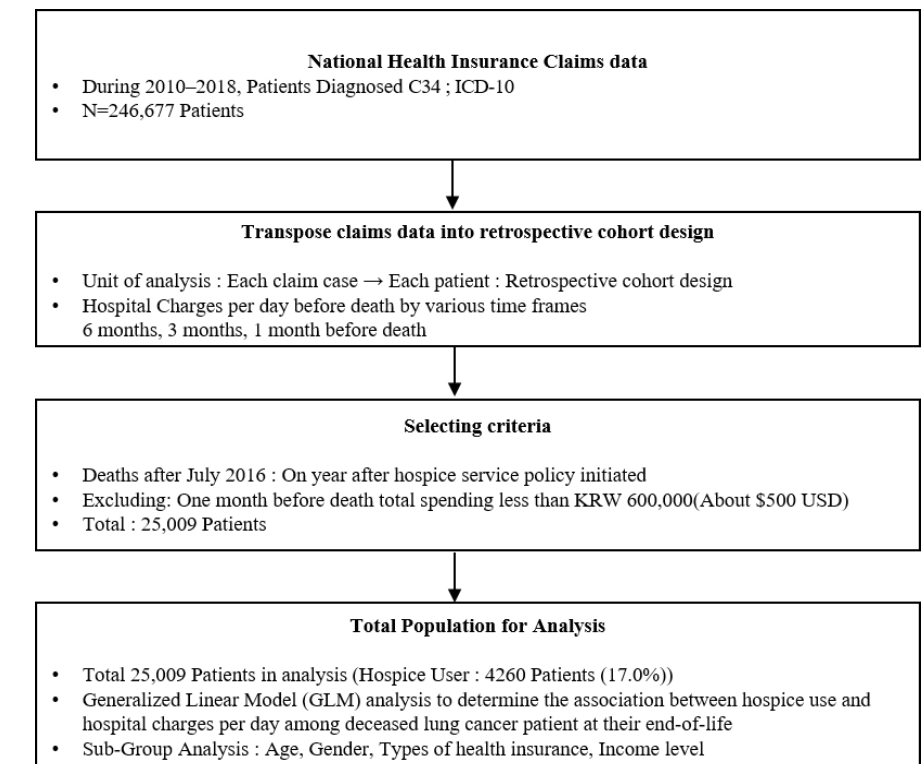
Figure 1. Flow chart of subject selection.